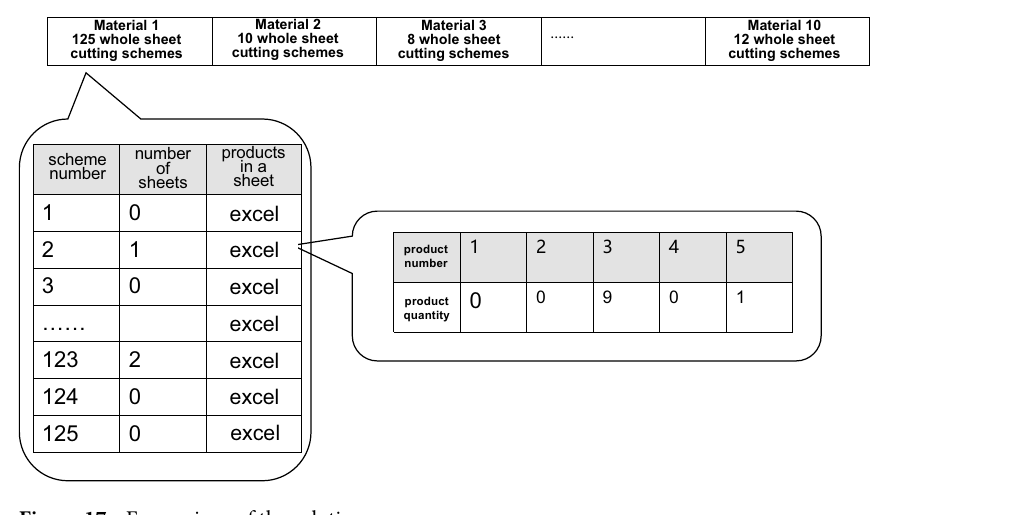
Figure 17. Expressions of the